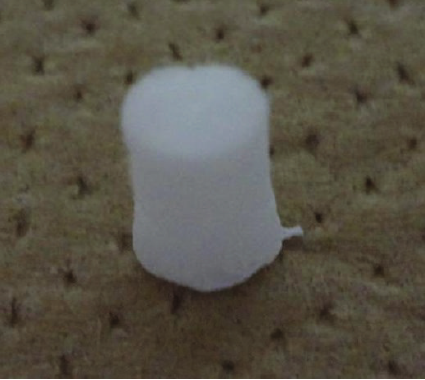
Figure 1: Freeze-dried sponge sample.